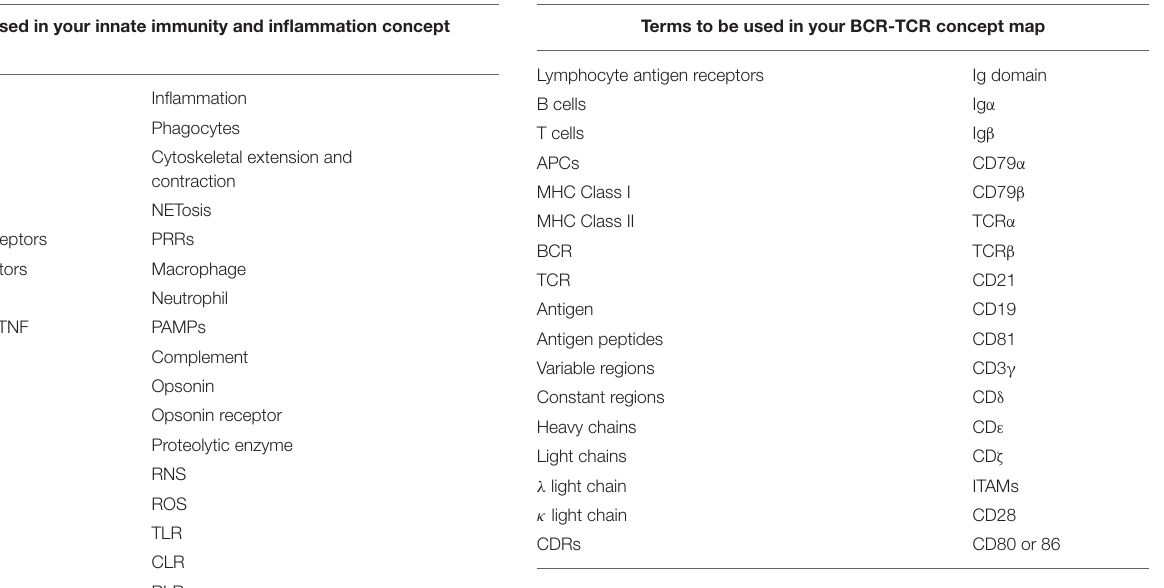
TABLE 5 | Sample concept map terms for an in class